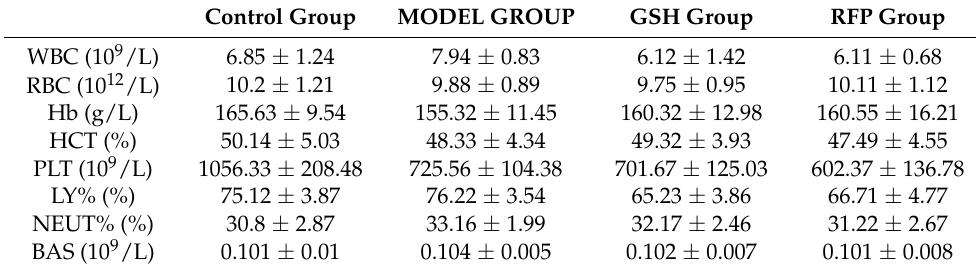
Table A3. Blood routine of